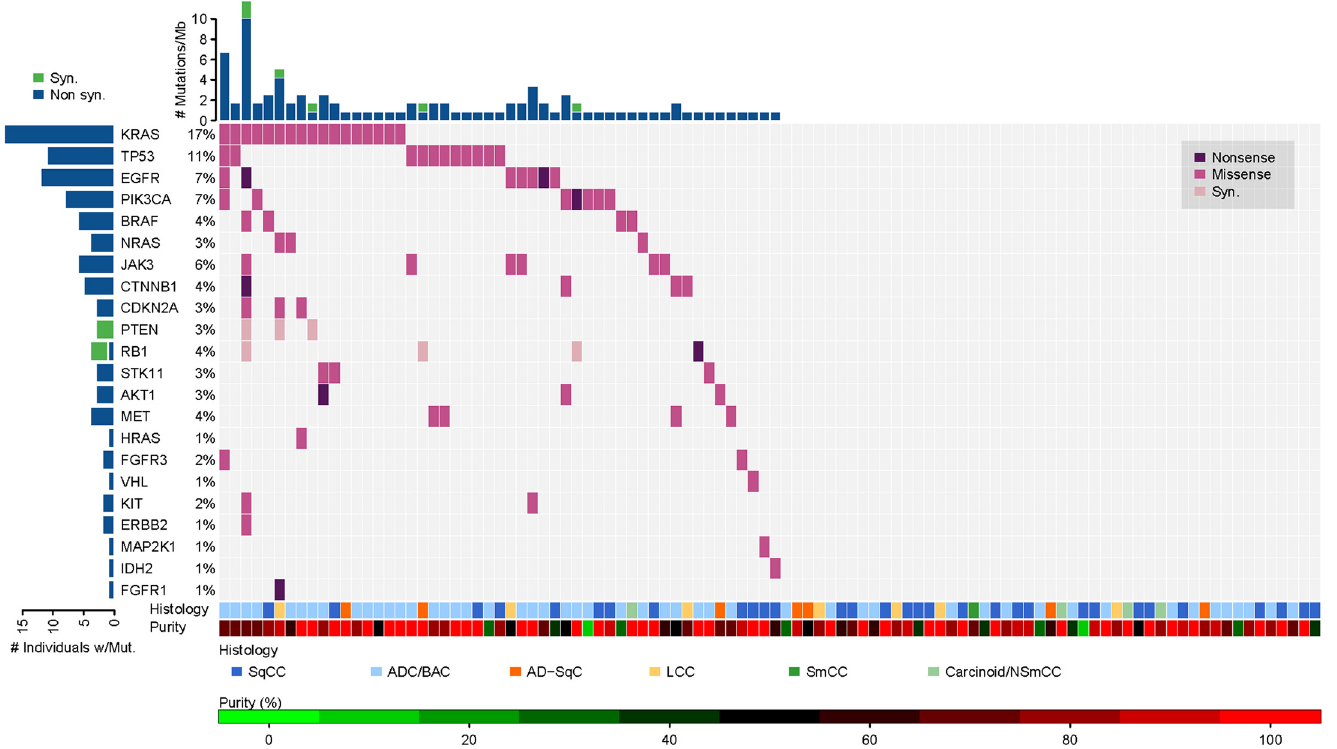
Fig 4. SNV Calling in Lung Cancer Specimens Using the UNCseq Assay for SNV Listed in the OncoMap System ( ‘ Conservative ’ SNV). Percentage, actual number of significantly mutated genes, and particular SNV types, nonsynonymous (nonsense, missense) and synonymous, are shown for each tumor sample in relation to its tumor histology and tumor purity. Abbreviations: SqCC: Squamous Cell Carcinoma; SmCC: Small Cell Carcinoma; ADC/BAC: Adenocarcinoma or Bronchio-alveolar Carcinoma; LCC: Large Cell Carcinoma; AD-SqC: Adenosquamous Carcinoma or Combined/Mixed; Carcinoid/ NSmCC: Carcinoid-Atypical, Carcinoid-Typical, or Non-small cell